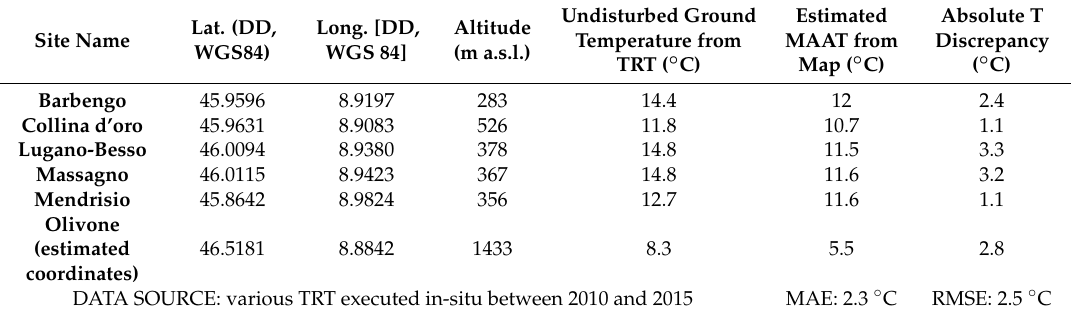
Table 3. Comparison between undisturbed ground temperatures from thermal response tests (TRTs) and